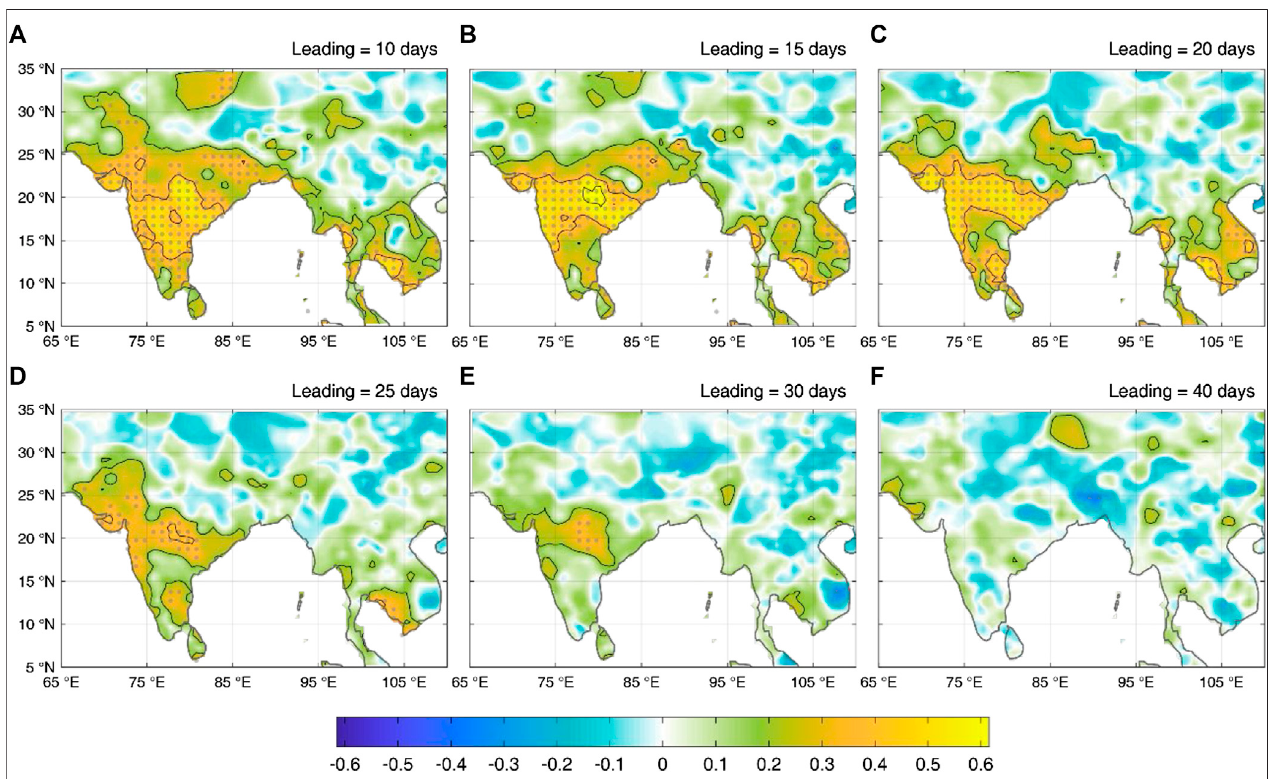
FIGURE 4 | Anomaly correlations of the observed and forecast precipitation anomalies on the intraseasonal timescale (20- to 80-day band-pass fi ltered) during 2004 – 2009 JJA at different forecast lead times (indicated at the top-right corners). Dotted areas passed the signi fi cance test at the 95% level (Student ’ s t test based on the effective degree of freedom). Contours start from 0.2 with an interval of